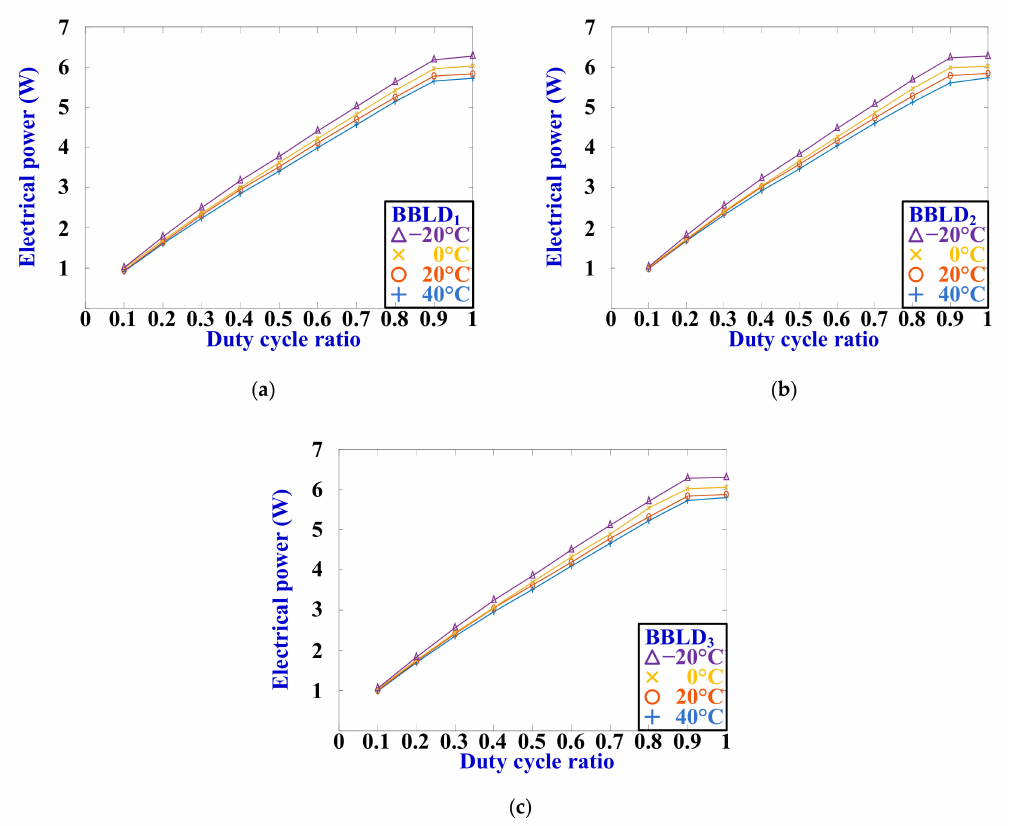
Figure 17. Variation of D pdcm to electrical power ( P e ( pdcm _ rms ) ) using RMS value calculation ( f s = 250 Hz). ( a ) BBLD 1 . ( b ) BBLD 2 . ( c ) BBLD 3